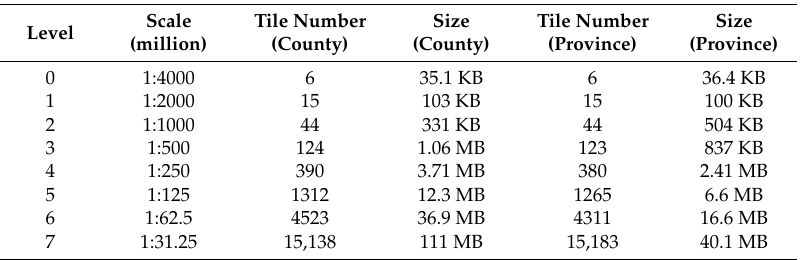
Table 4. The datasets for the parallel conversion test.